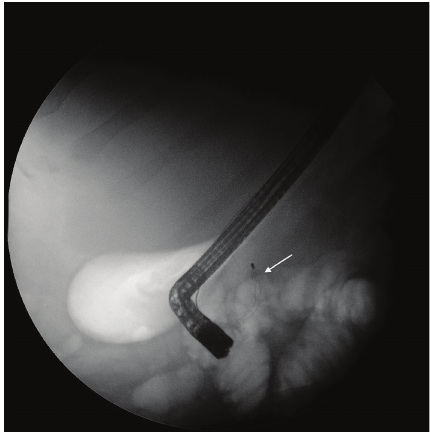
Figure 3: Basket/stone complex (arrow) lodged in the distal CBD after attempted mechanical lithotripsy.